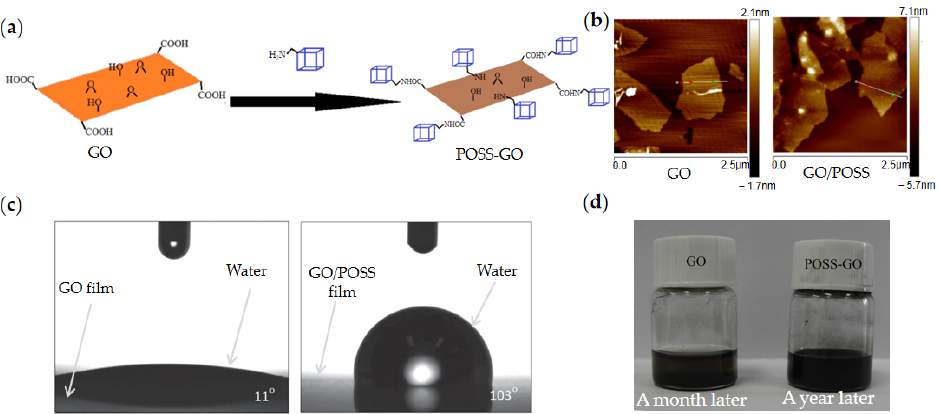
Figure 3. Schematic preparation of POSS/GO nanoplates by surface grafting reaction between amine functionalized POSS and oxygen ‐ containing groups on the surface of GO ( a ) and AFM images of GO and POSS/GO ( b ) [74]; Water contact angle of GO (11°) and POSS/GO (103°) ( c ) and sedimenta ‐ tion performance of GO fluid and POSS/GO fluid ( d ) [74].